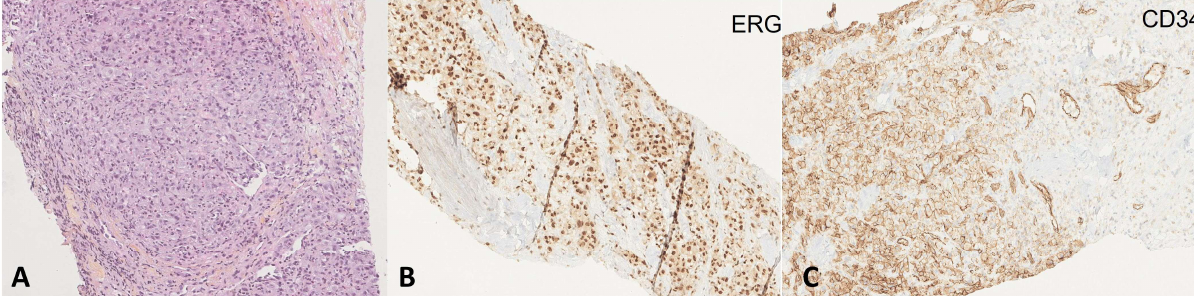
Figure 6. ( A ) Angiosarcoma with areas of sheet-like growth of epithelioid large cells and some vas- cular cavities (×100 magnification) . ERG (×100 magnification) ( B ) and CD34 expression ( C ) con- vascular cavities ( × 100 magnification) . ERG ( × 100 magnification) ( B ) and CD34 expression firmed the diagnosis of angiosarcoma and ruled out an ATC (×100 magnification). ( C ) confirmed the diagnosis of angiosarcoma and ruled out an ATC ( × 100